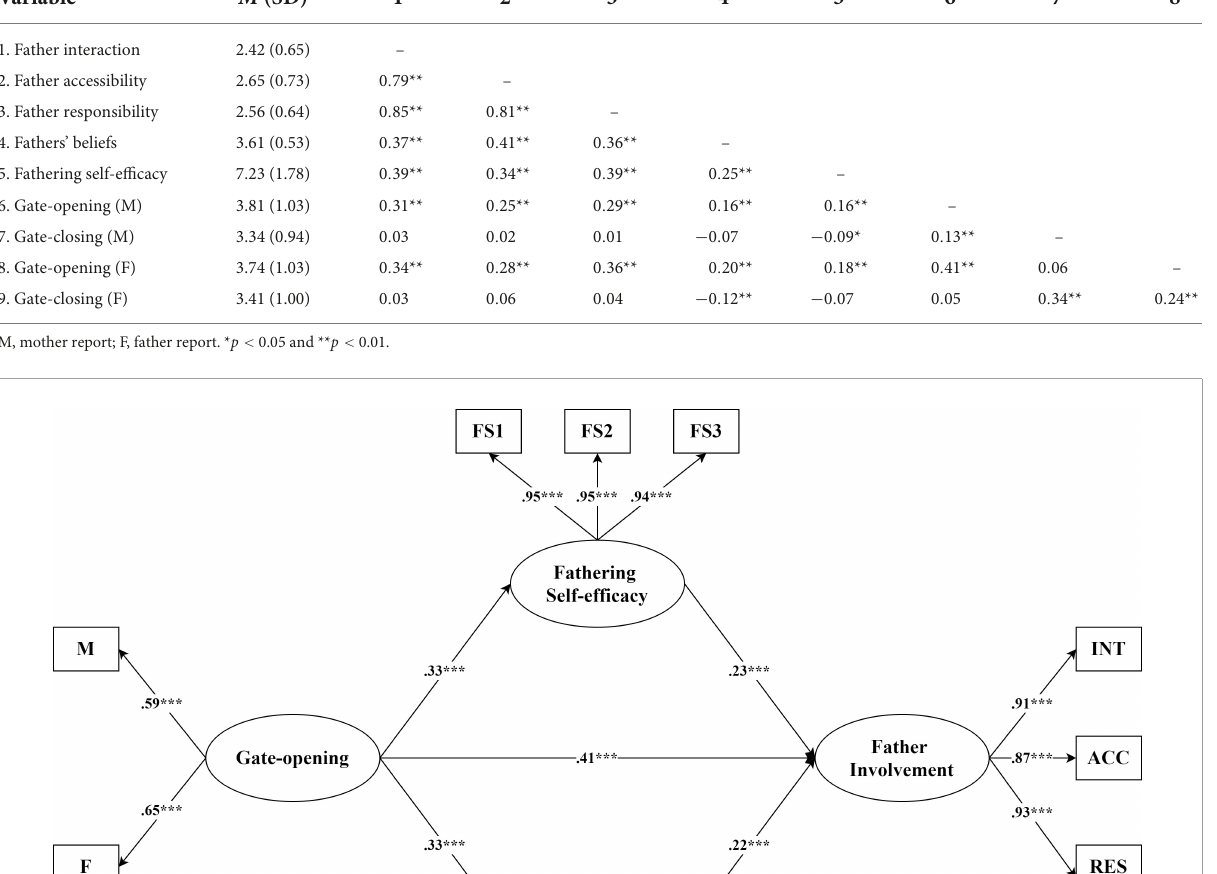
TABLE 2 Correlations, means and standard deviations of father involvement, fathers’ beliefs about parental roles, fathering self-efficacy, and maternal gatekeeping. Variable